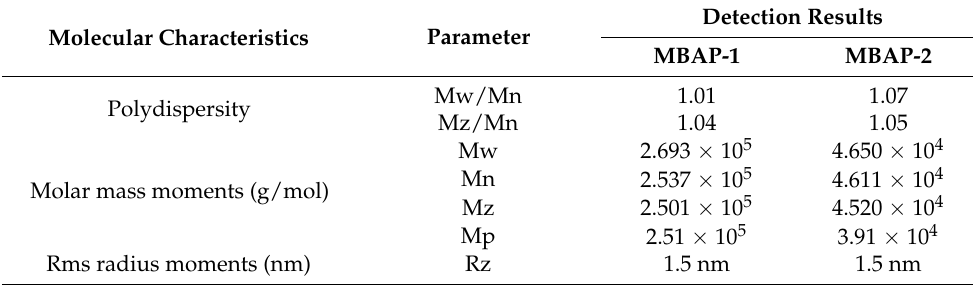
Table 1. The molecular parameters of MBAP-1 and MBAP-2 determined by SEC-MALLS-RI.